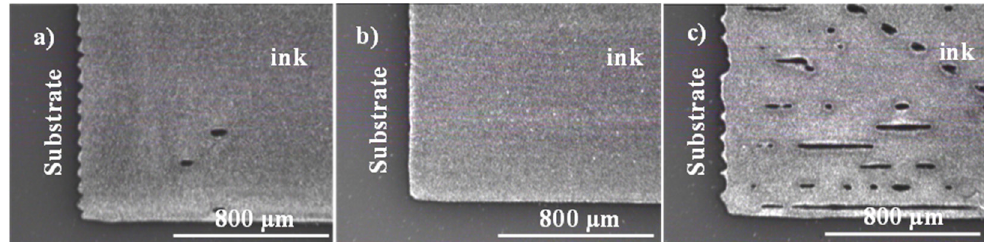
Figure 3. Inkjet-printed pattern: ( a ) 15 µ m drop spacing, ( b ) 20 µ m drop spacing, and ( c ) 25 µ m drop spacing.